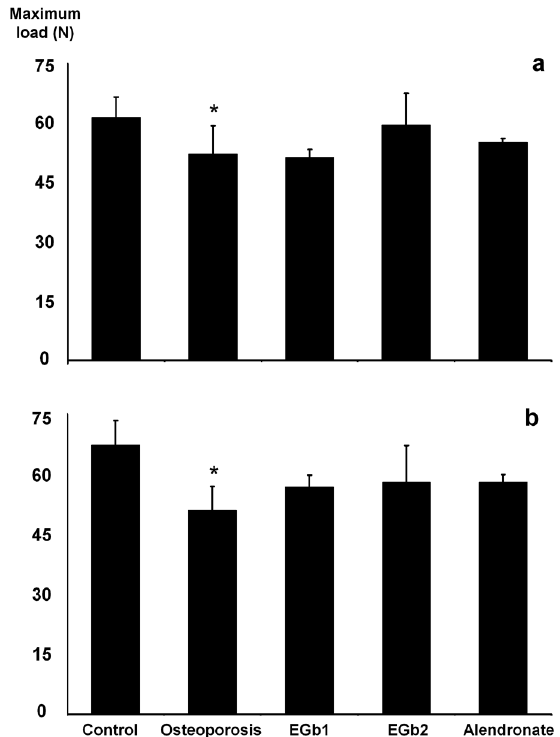
Figure 3 - Mechanical properties of the three-point bending test- Maximum load. a - 20 days of treatment. b - 30 days of treatment. *p<0.05 when the control group was compared to the osteoporosis group (Student`s t-test).